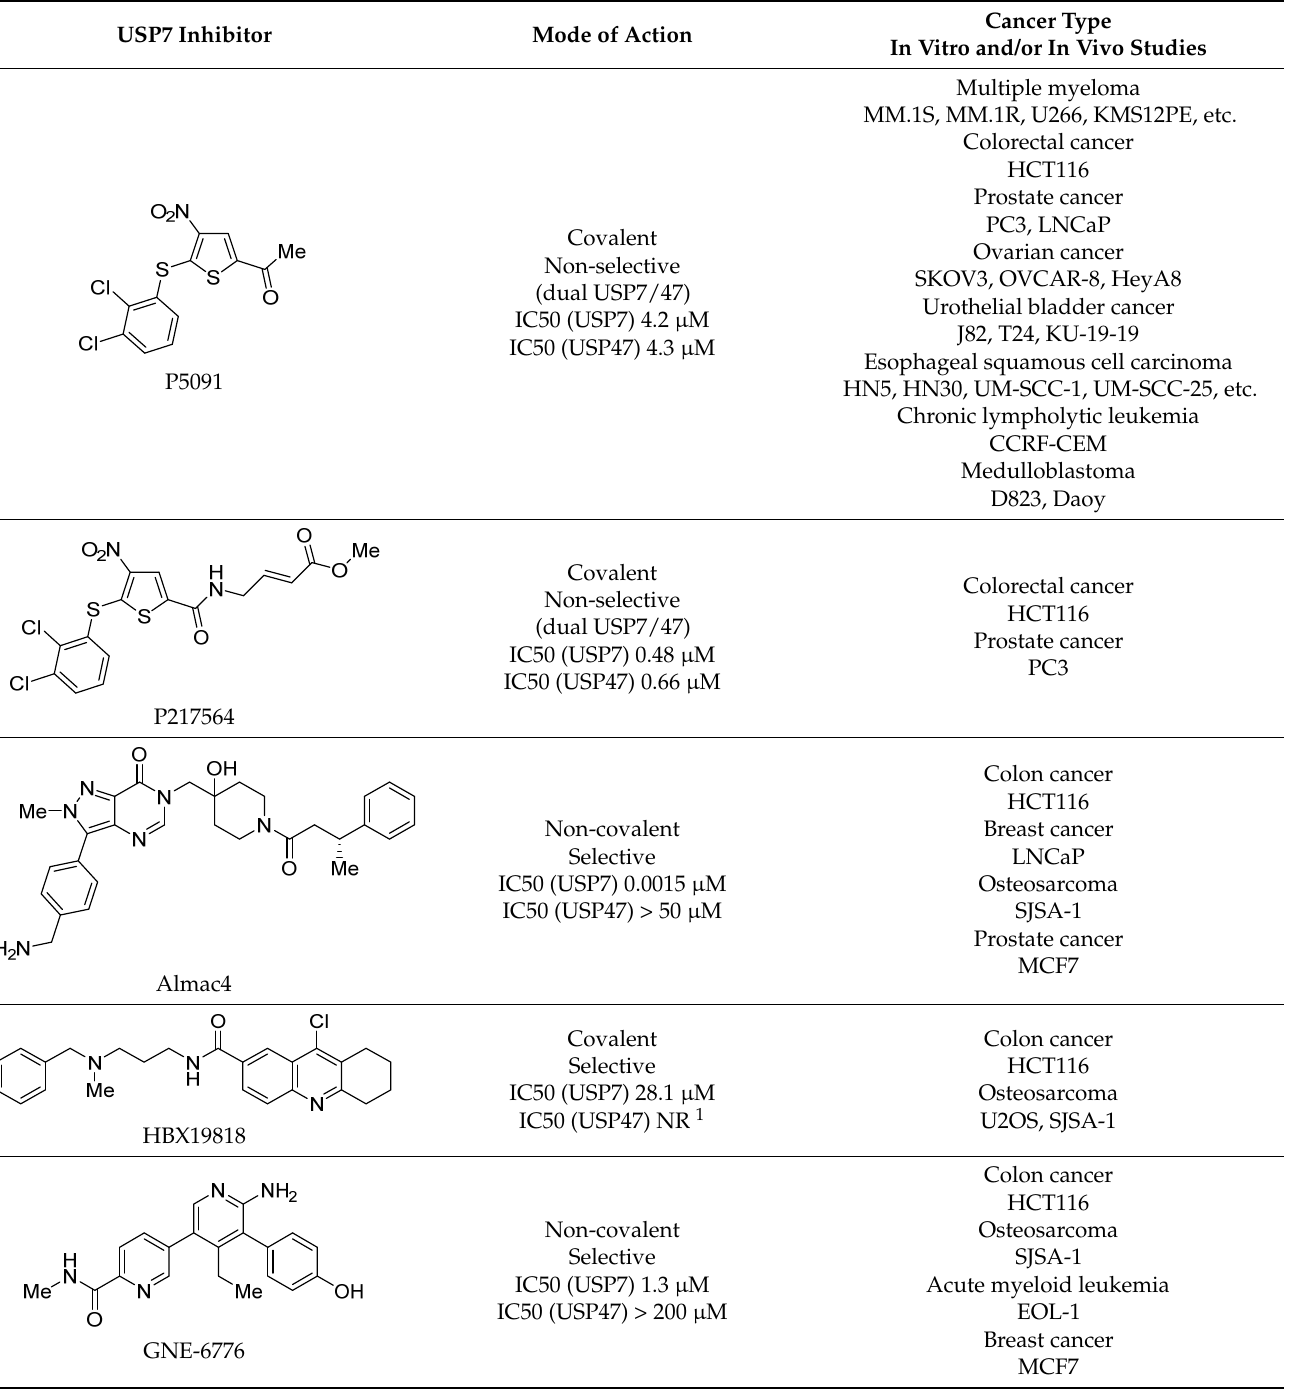
7 of 16 Figure 2. Small molecule inhibition of USP7 and its effect on anti-tumor immune response: ( A ) Ini- tiation of p53-dependent apoptosis in tumor cells via p53/MDM2 pathway. ( B ) Decreasing PD-L1 levels sensitize tumor cells to T cell-mediated cytotoxicity by reducing PD-L1 interaction with PD- 1. ( C ) Overcoming the immune tolerance of tumor via lowering IL-10 levels. ( D ) Reducing immu- nosuppressive functions of Tregs via destabilization of Tip60 and Foxp3. ( E ) Promotion of local anti-